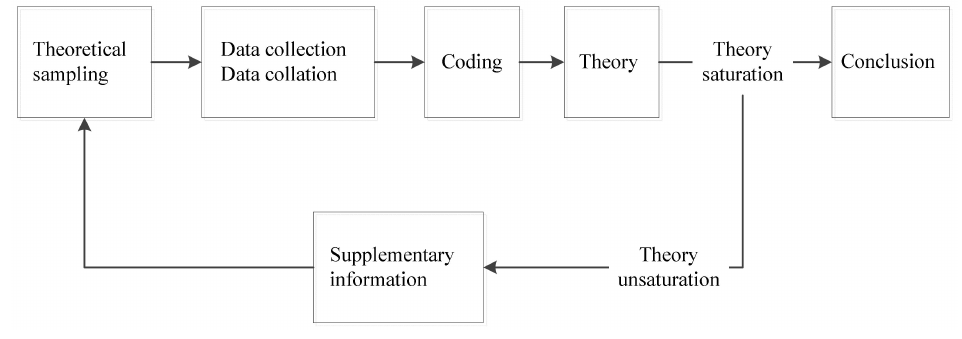
Figure 2. Grounded theory approach research process.